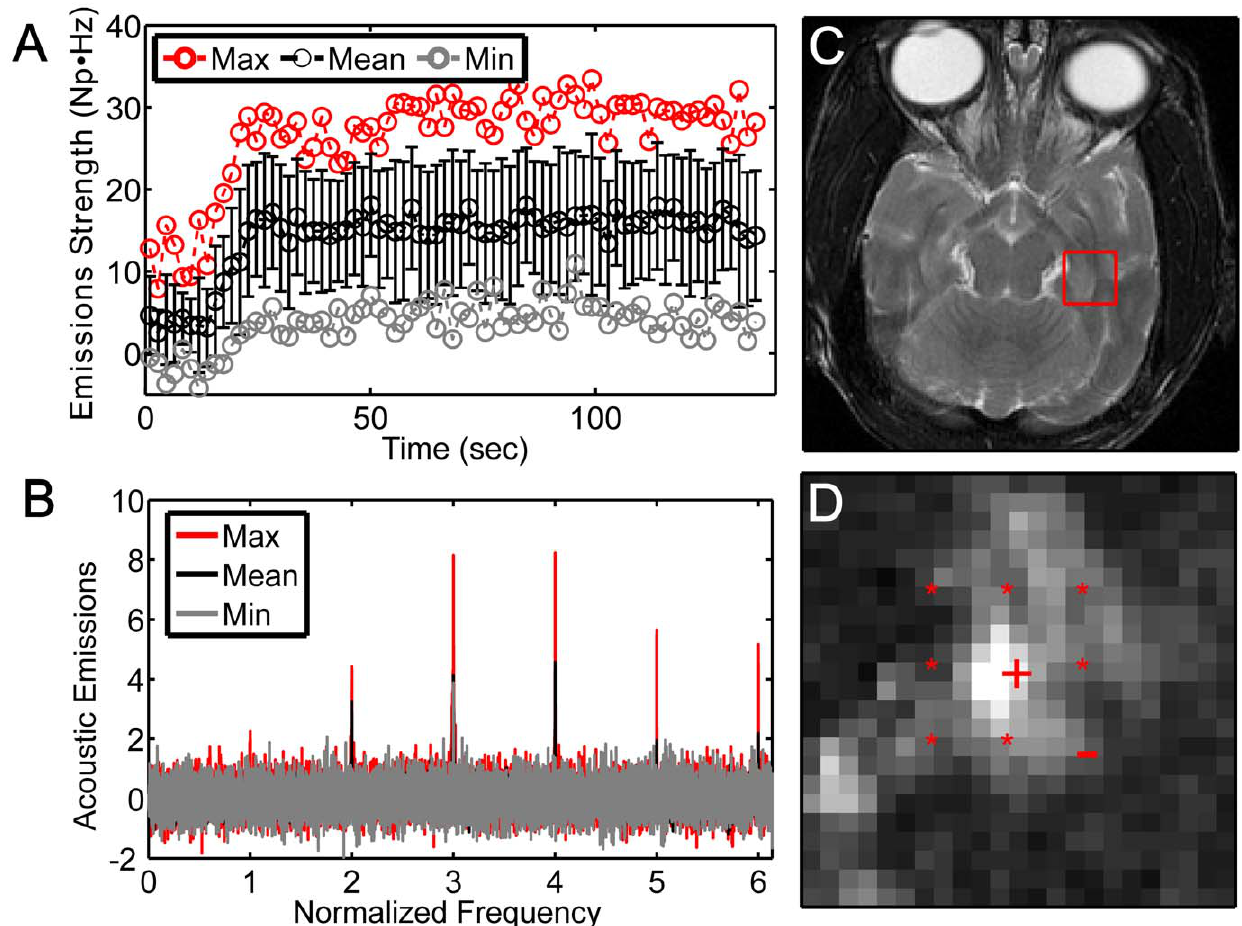
Figure 4. Example acoustic emissions and MRI for a multi-target sonication centered on the LGN in monkey # 3. (A) Harmonic emission signal strength as a function of time (212 kPa; Mean: mean signal 6 S.D. for the nine subsonications; Min./Max.: subsonications with smallest and largest signals). The increase in emissions due to the arrival of the microbubbles at about 20 s is evident. Note also the constant level of emissions over the duration of the rest of the sonication. Harmonic emissions greater than zero at time=0 were presumably due to microbubbles present in the circulation from an earlier sonication. (B) Relative power spectra averaged between 25–140 s showing strong harmonic emissions without evident broadband emissions. (C) T2-weighted image showing the location of the sonication. (D) MRI contrast enhancement observed in T1- weighted MRI after Gd-DTPA injection (percent enhancement shown). The subsonication targets are indicated (‘ + ’ subsonication target with strongest signals; ‘ 2 ’ target with smallest signals; ‘*’